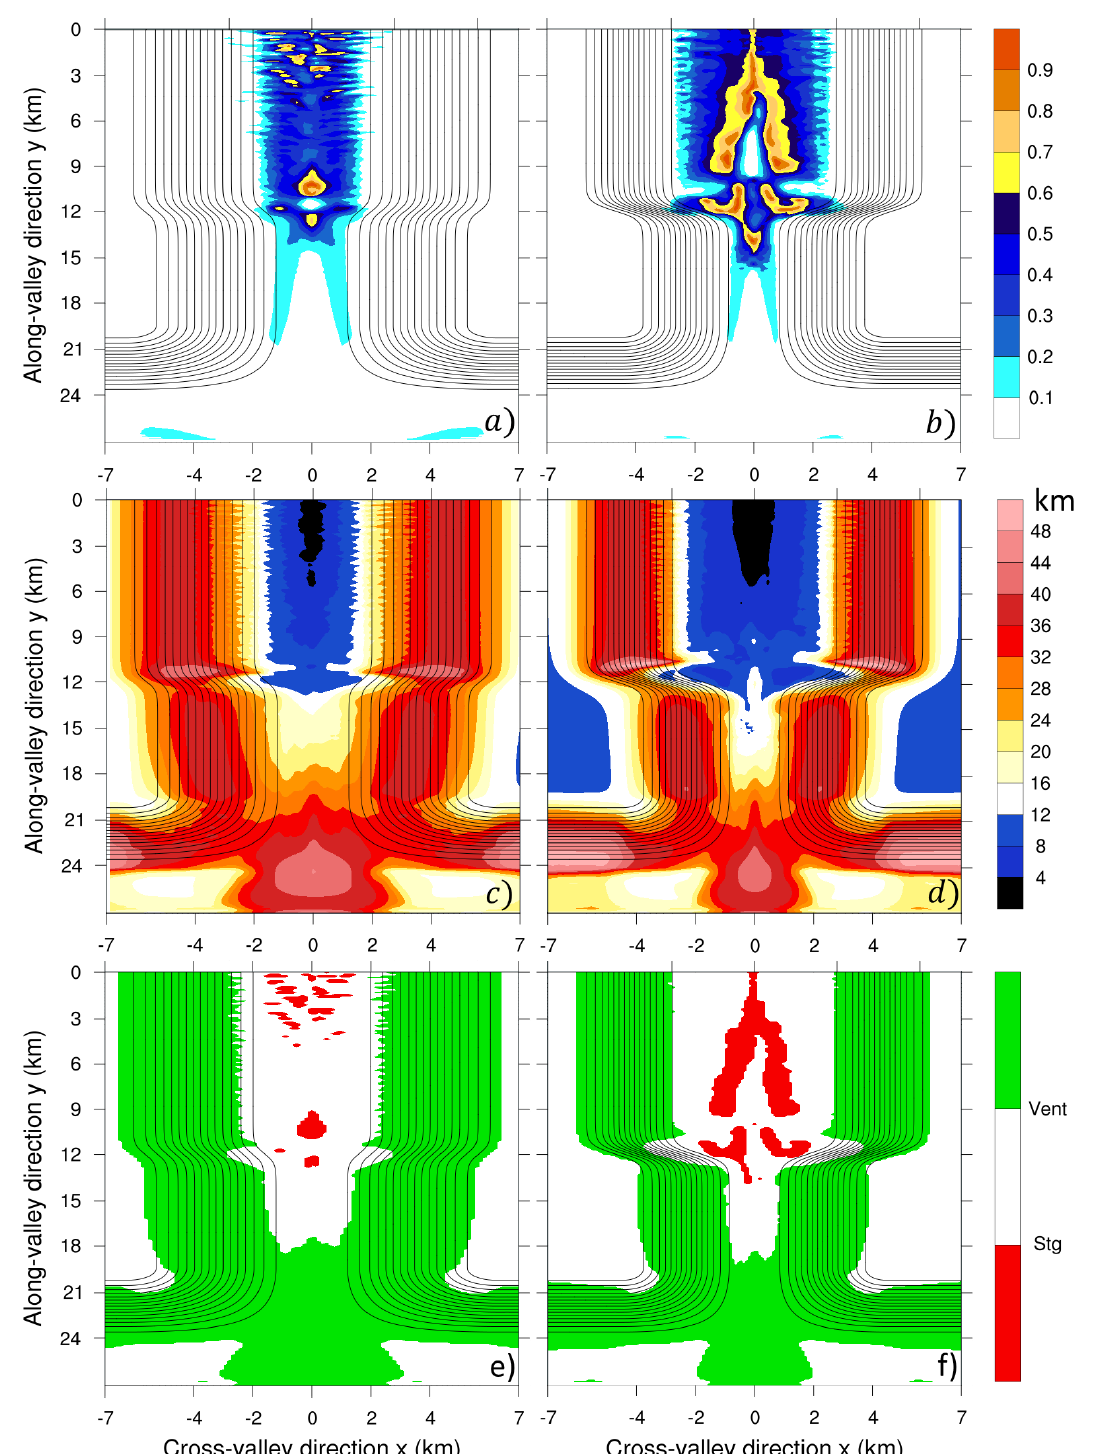
Figure 7. Contour plots of the recirculation factor ( R , top row), contour plots of the wind run ( S , middle row) and zones prone to critical stagnation and ventilation (bottom row) for P 1 ( a , c , e ) and P 2 ( b , d , f ) simulations overlaid with contour lines of the terrain height using a 50 m interval. Each point in the domain has been averaged over 15 min and over the first 30 m above the ground level. The unit for S is